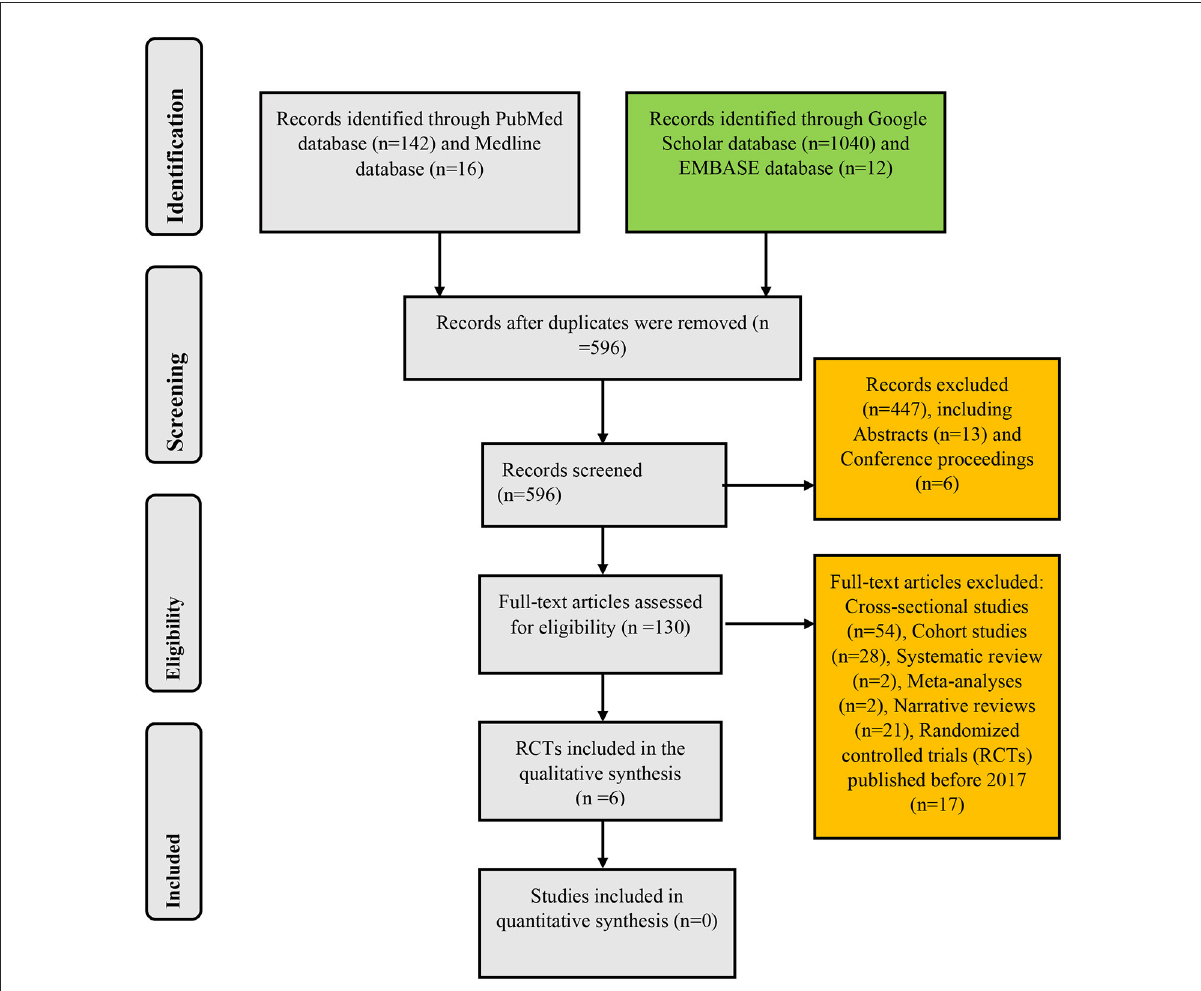
FIGURE1 Algorithm for inclusion of randomized controlled trials on the use of probiotics in childhood asthma and atopic disorders.